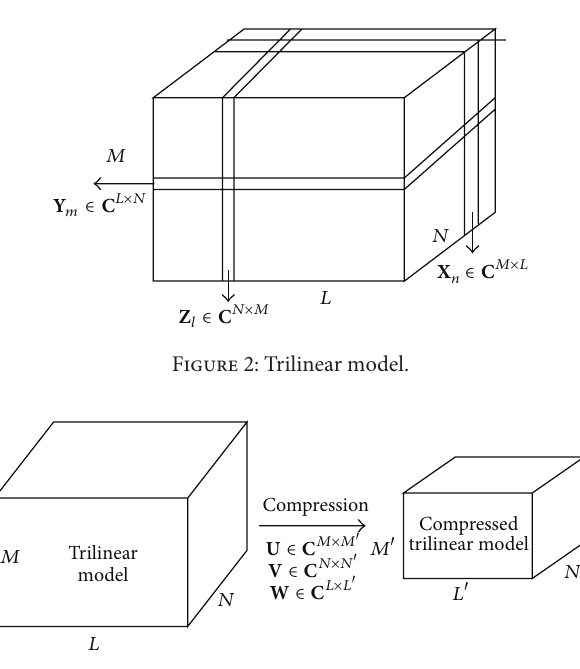
Figure 3: The compression of trilinear